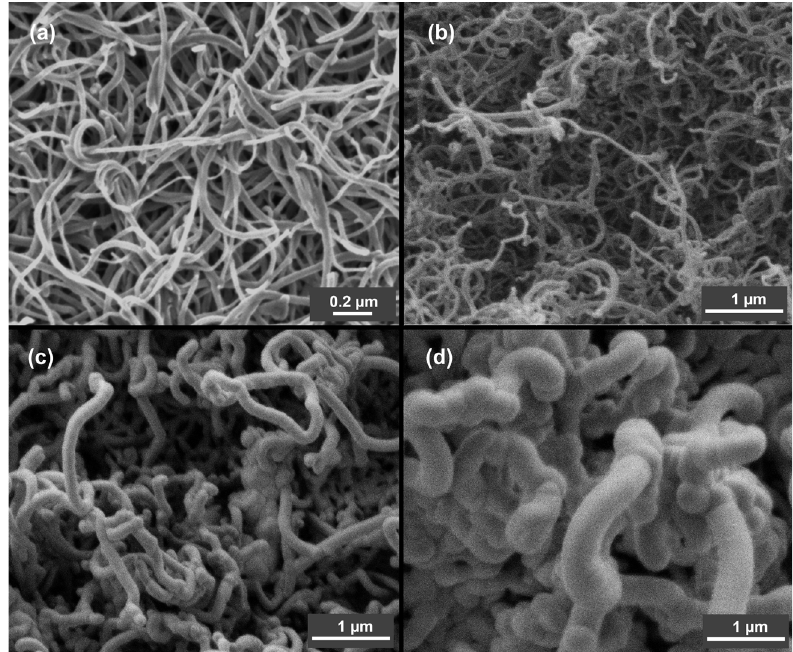
Figure 5. SEM micrographs of buckypapers: as prepared (a), after 1 (b), 3 (c) and 10 (d) minutes of plasma treatment with tetrafluoroethane.